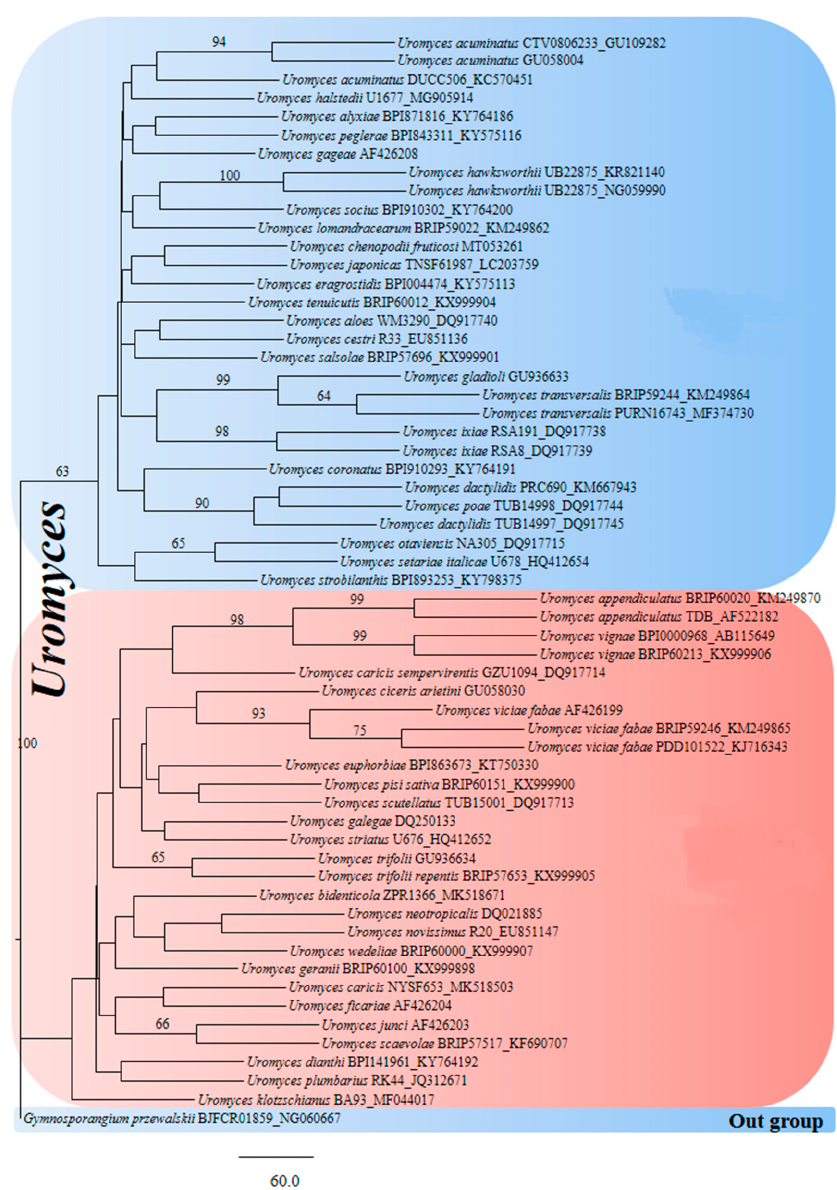
Figure 4. Phylogram generated from PAUP analysis of Uromyces species of LSU sequences. The scale bars indicate 60 changes and outgroup Gymnosporangium przewalskii BJFCR01859_NG060667. Bootstrap values of MP equal to or greater than 60% are given above branches, and 58 sequences are included in the phylogenetic analyses. The best maximum parsimony (MP) dataset consists of 873 total characters, of which 600 were constant, 125 parsimony-informative, and 148 parsimony- non-informative. The parsimony analysis of the data matrix showed 1000 equally parsimonious trees with a length of 625 steps in the first tree (CI = 0.550, RI = 0.708, RC = 0.389, HI = 0.450).